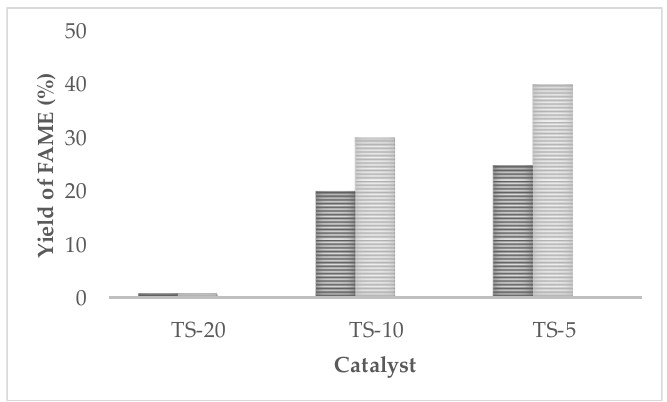
Figure 5. Percentage of FAMEs formed in the methanolysis reaction of soybean and castor oils.